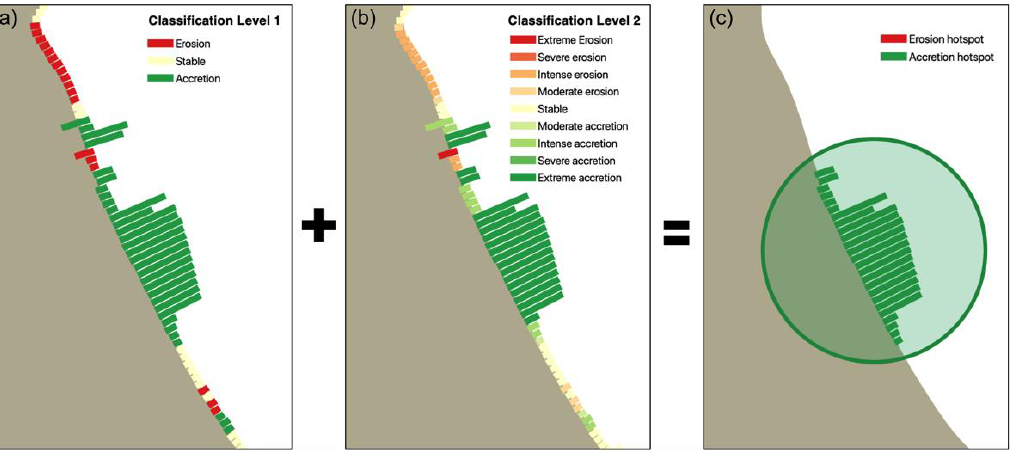
Figure 6. Hotspot analysis method. ( a ) Coastline change classification on Level 1; coastal segments are defined hotspots when 20 consecutive transects belong to the “erosion” or “accretion” class (with 1 transect tolerance). ( b ) Coastline change classification on Level 2; hotspots showing “extreme” change rates on average (>5 m/year) are filtered. ( c ) Filtered “extreme erosion hotspot”.